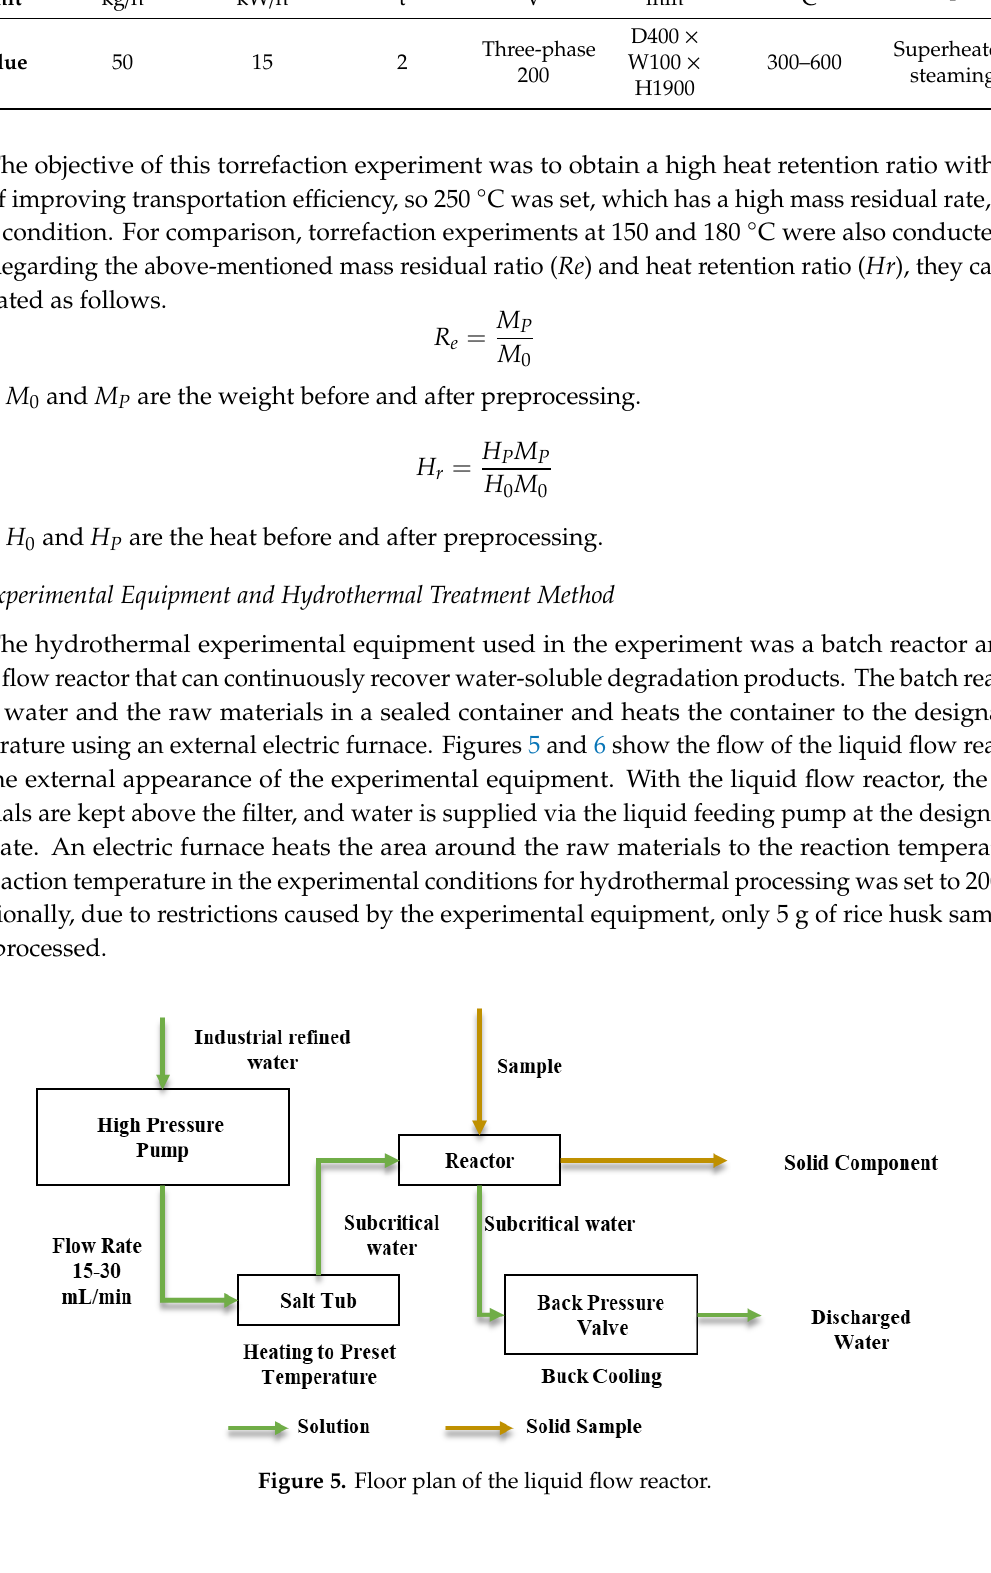
Figure 6. Device diagram of the liquid flow reactor [18]. 2.3. Evaluation of Transportation Cost Using a Resource Island Model To evaluate the efficiency of transportation of products by torrefaction and hydrothermal treatment, the effect of reducing transportation costs was estimated by introducing the resource island model [ 19 ], imagining the transportation of rice husks from the Ayeyarwady district in Myanmar, where there is a large surplus of rice husks, to a region where the supply of rice husks is low.